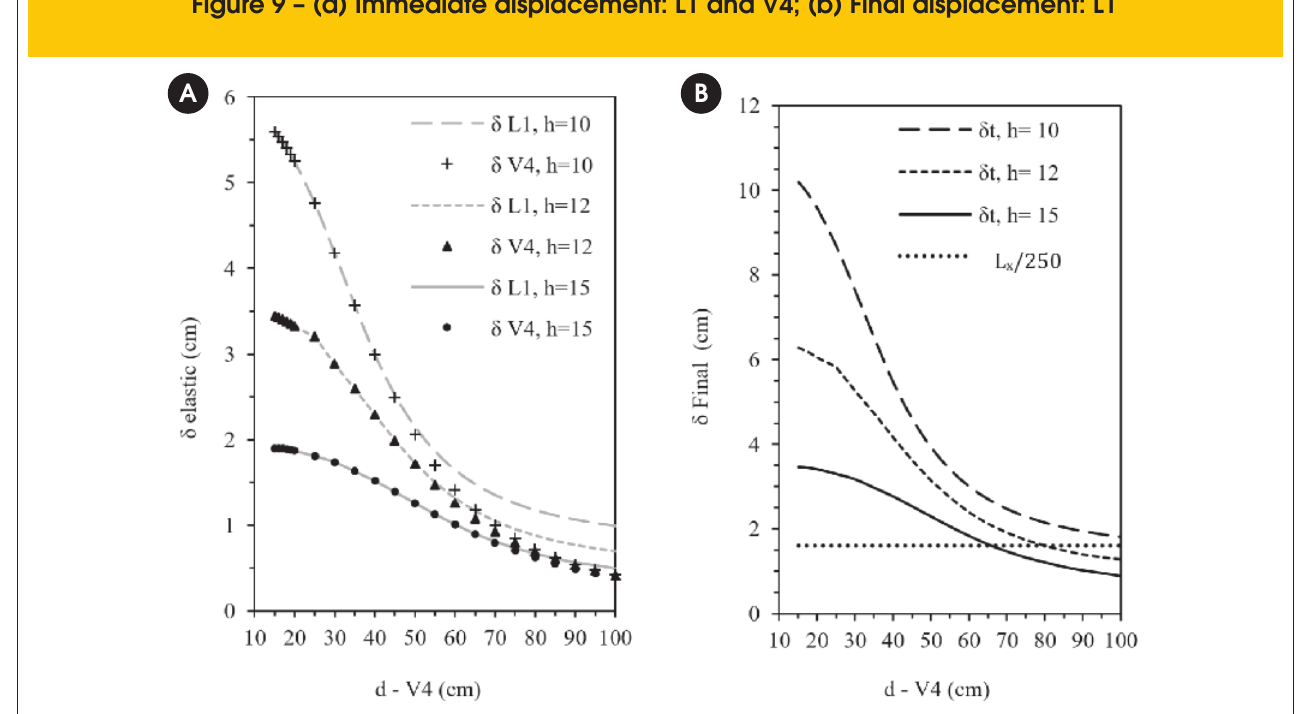
Figure 9 – (a) Immediate displacement: L1 and V4; (b) Final displacement: